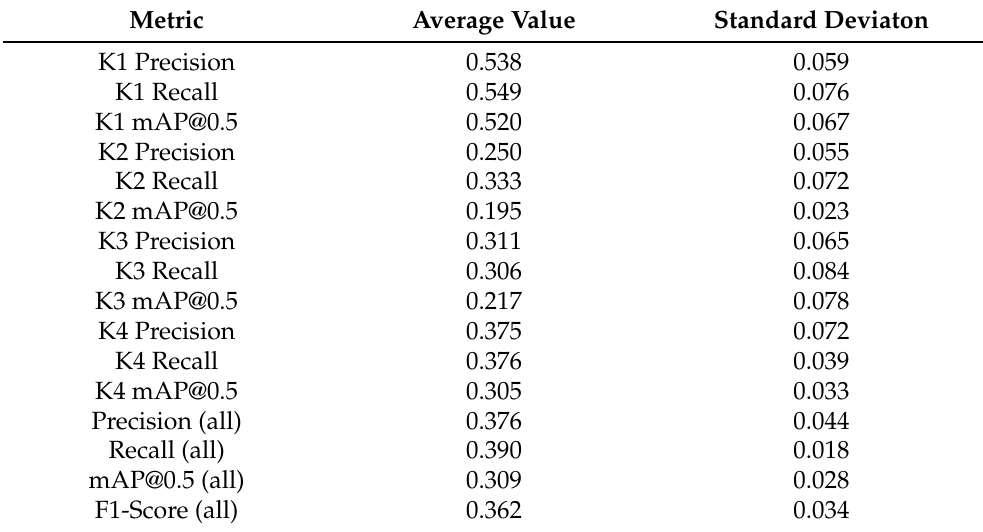
Table 8. Base model + classical augmentation techniques evaluation scores.